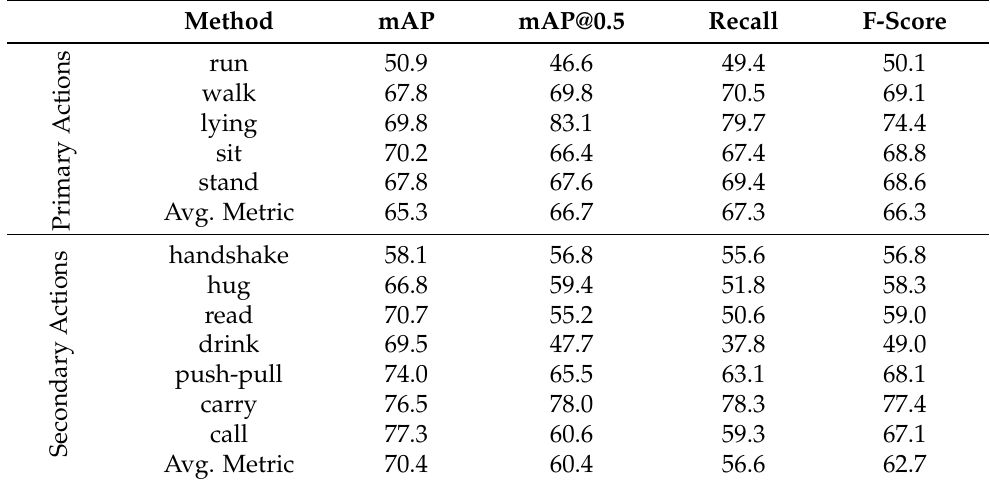
Table 2. Performance evaluation for each individual action category for YoloV5s6